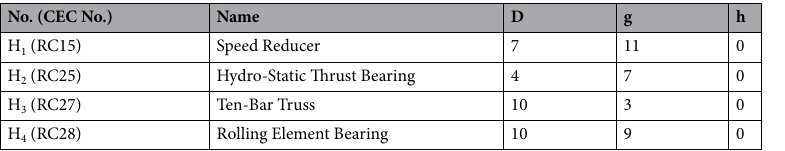
Table 7. Real-world constrained optimization problems. D, Dimensions; g, Number of inequality constraints; h, Number of equality constraints.